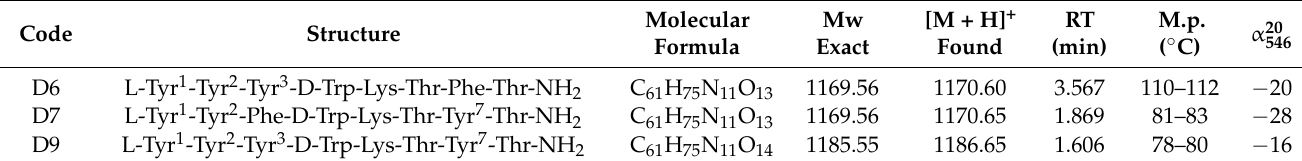
Table 2. Structures, data and constants of newly synthesized analogs of BIM-23052 containing L-amino acid at position